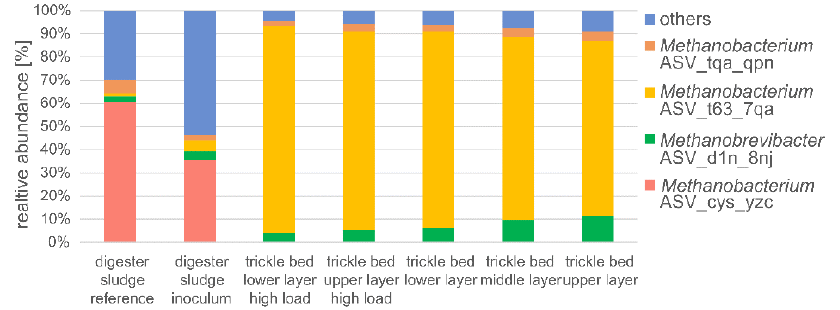
Figure 10. Dynamics of the euryarchaeotal ASVs obtained by 16S rRNA gene amplicon sequencing displayed as relative abundance (%) within the phylum Euryarchaeota. ASVs with a global relative abundance <1% are summarized as “others.”